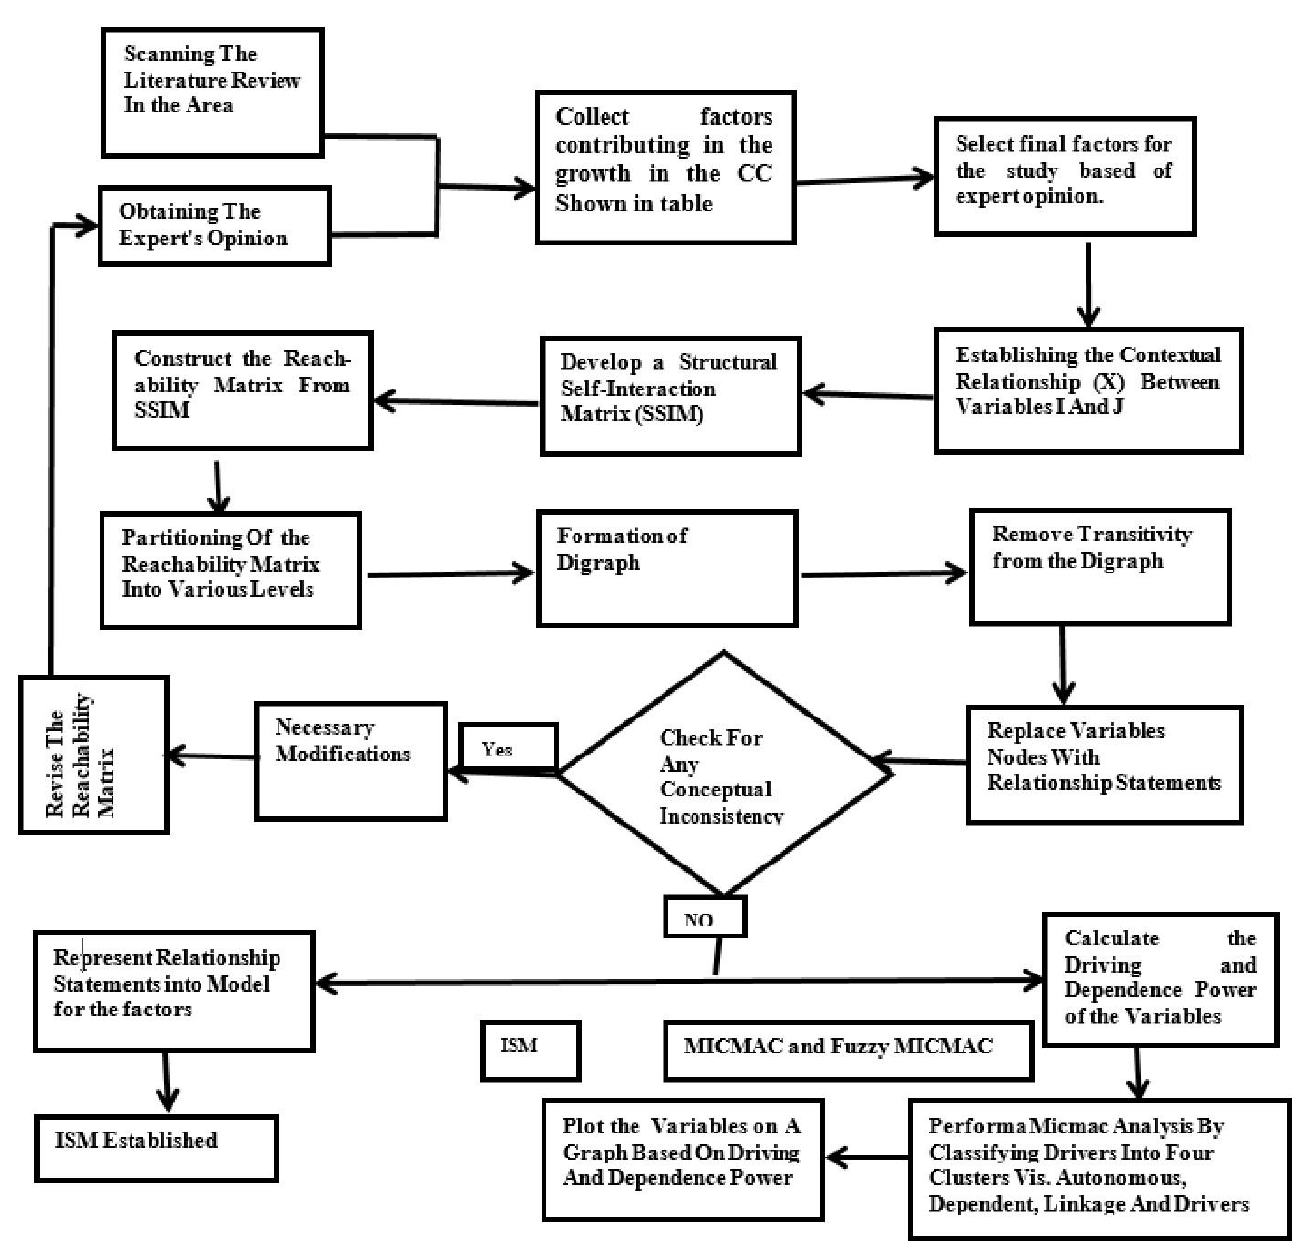
Figure 2. Flow diagram for preparing the ISM